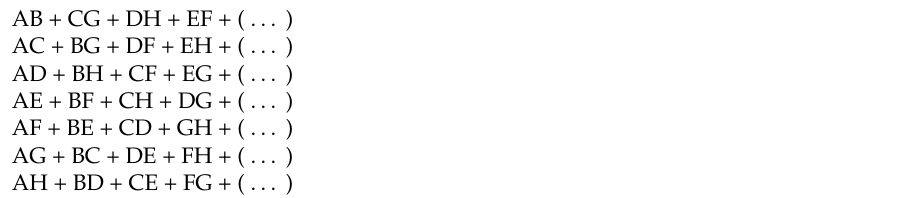
Table 3. Alias structure (only order 2) considered in the 2 8-4 fractional factorial design a .